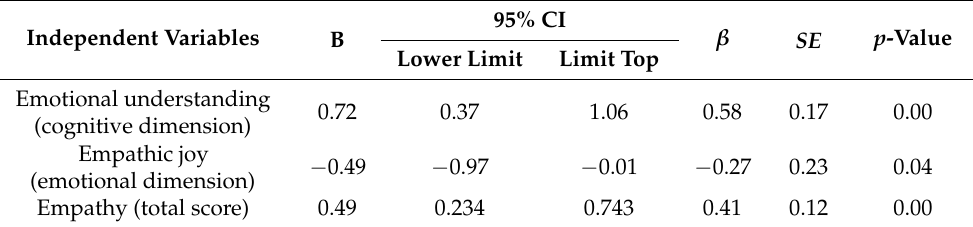
Table 3. Regression of the “negative attitudes toward transsexuality” from the variables of cognitive and emotional empathy and bullying in university students. 95% CI β SE p -Value Independent Variables B Lower Limit Limit Top Emotional understanding 0.72 0.37 1.06 0.58 0.17 0.00 (cognitive dimension) Empathic joy − 0.49 − 0.97 − 0.01 − 0.27 0.23 0.04 (emotional dimension) Empathy (total score) 0.49 0.234 0.743 0.41 0.12